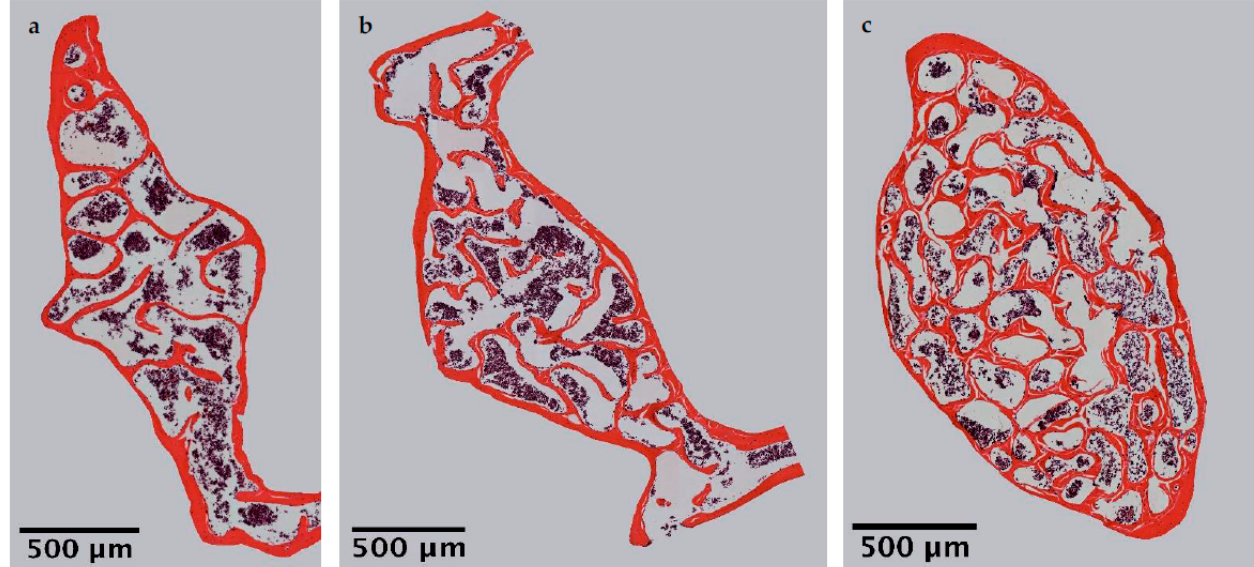
Figure 1. Microscopic overviews of vertebral bodies L3 stained with hematoxylin-eosin. Images taken at 40× magnification were merged. Mice were immunized with ( a ) testicular homogenate in adjuvant (EAO), ( b ) adjuvant alone or ( c ) remained untreated.